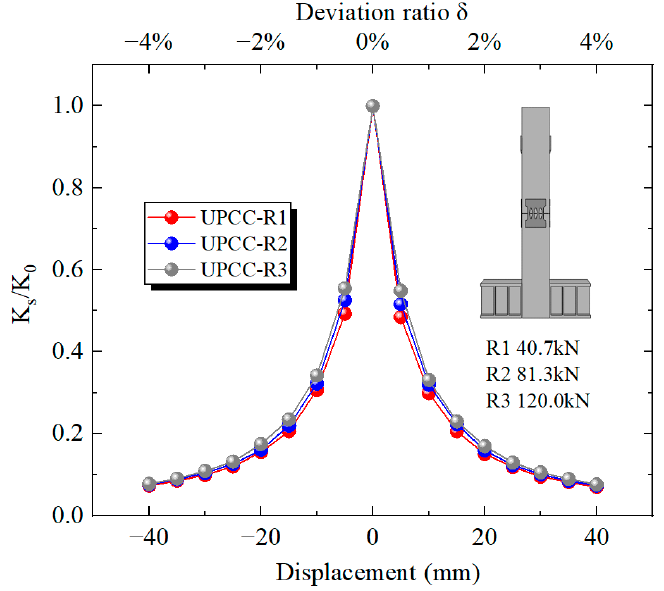
Figure 22. Stiffness degradation curve under different initial prestress.